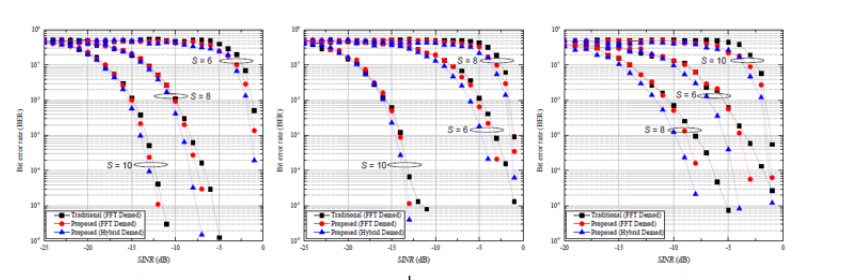
Table 3. SINR (in dB) threshold comparison. Traditional, proposed, and hybrid schemes are presented by green, blue, and red circles, respectively. Int. Des.